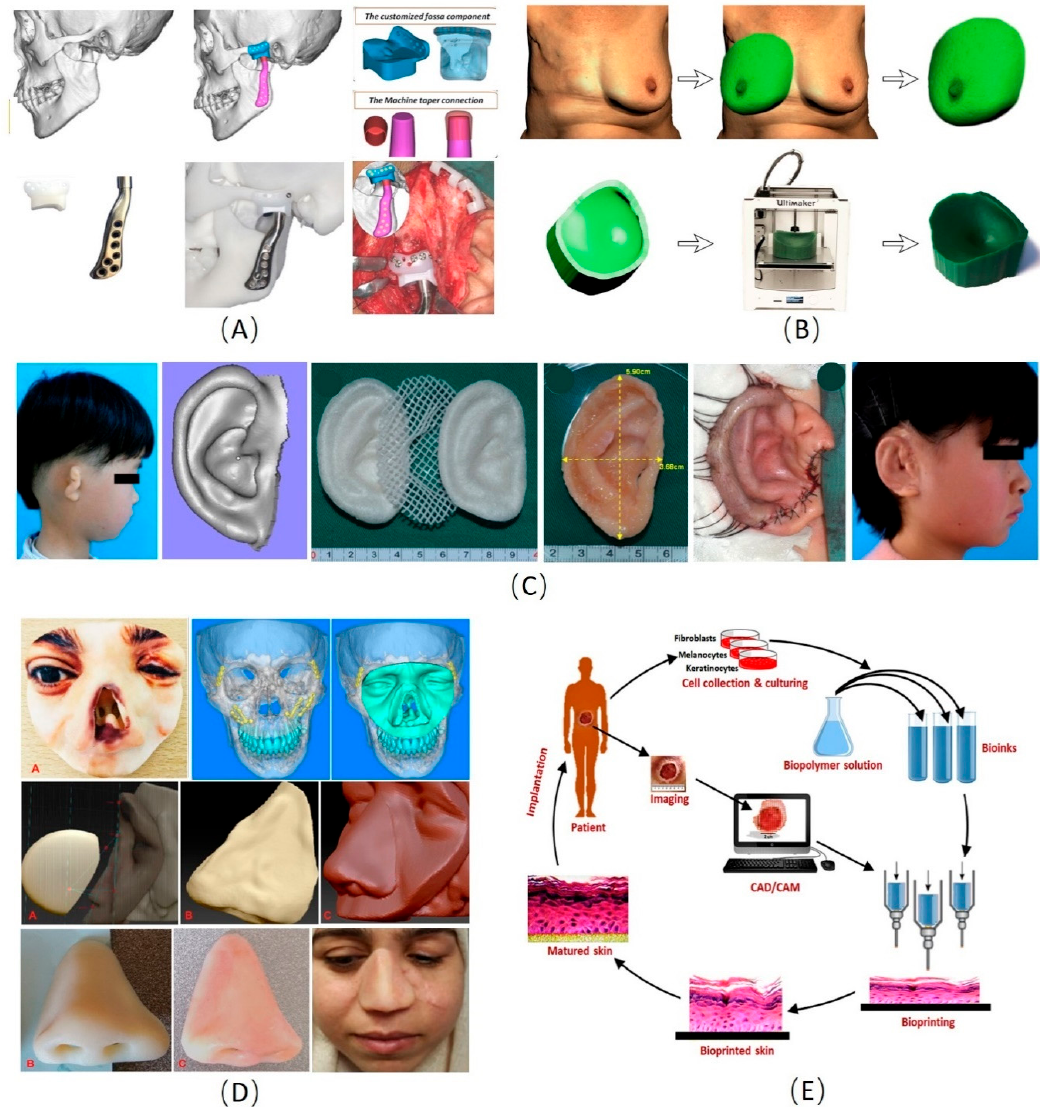
Figure 2. Examples of the applications of three-dimensional (3D) manufacturing technology in plastic and cosmetic surgery [108–126]. ( A ) The 3D manufacturing technology for temporomandibular joint reconstruction [111]. ( B ) Design of a patient-specific template for unilateral breast reconstruction. The contralateral breast is virtually isolated and mirrored based on 3D photography. Extrusion of the outer rim of the virtual breast provides a flat base. Finally, the design is printed using a 3D printer [125]. ( C ) The process of 3D printing PCL and PGA sca ff old and autologous residual ear cartilage co-culture to generate an individualized auricular implant [58]. ( D ) The process of obtaining a nasal defect model and make prosthesis to repair the nasal defect by the 3D manufacturing technology [113]. ( E )